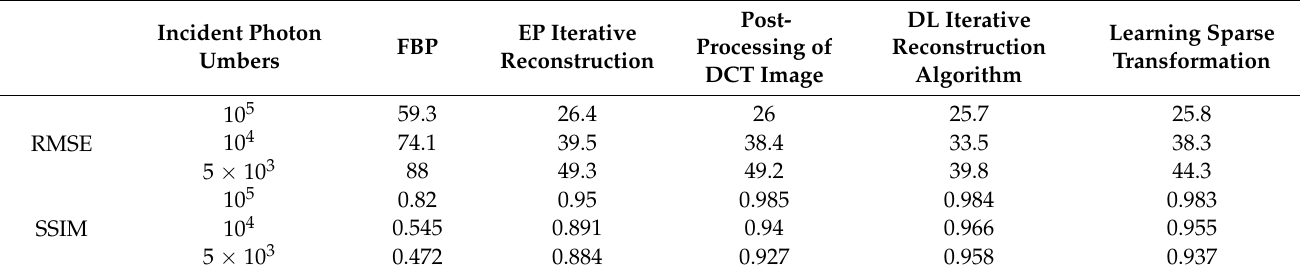
Table 1. RMSE (HU) and SSIM of different